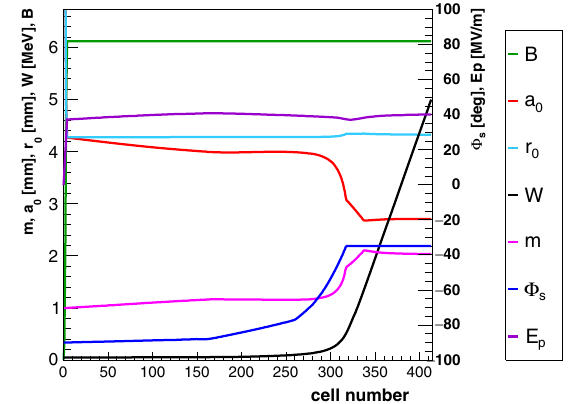
FIG. 19. Cell parameters for conceptual RFQ design of the 2.5- MeV proton accelerator proposed in this paper.